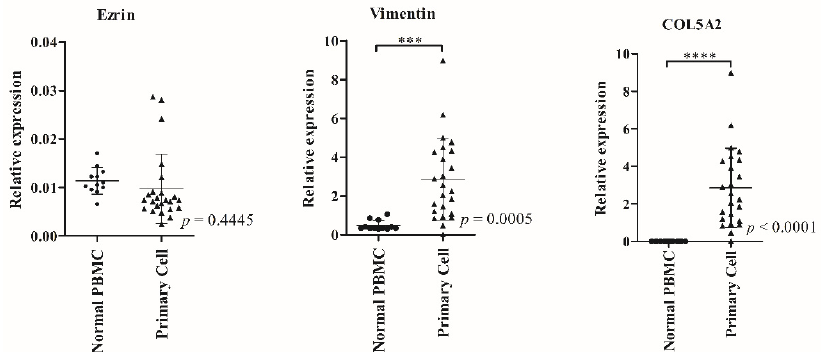
Figure 7. Comparison of the expression levels of three osteosarcoma (OS)-specific candidate genes